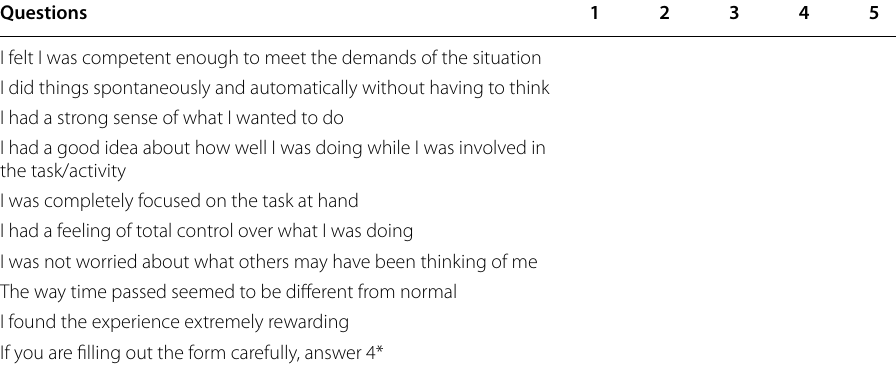
Table 6 Flow state scale (proposed by Jackson and Eklund (2002) and validated for the gamification domain by Hamari and Koivisto